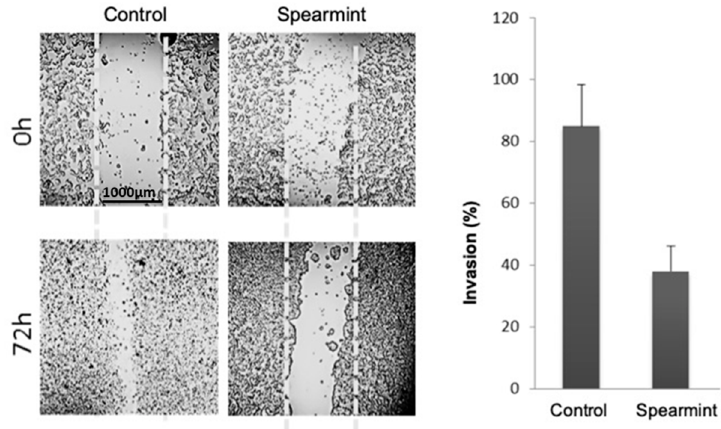
Figure 11. Effect of spearmint phenolic extract (at a concentration of 500 μ g/mL) on the invasion properties of HT-29 colorectal cancer cells in a wound-closure assay (at 0 h and 72 h).